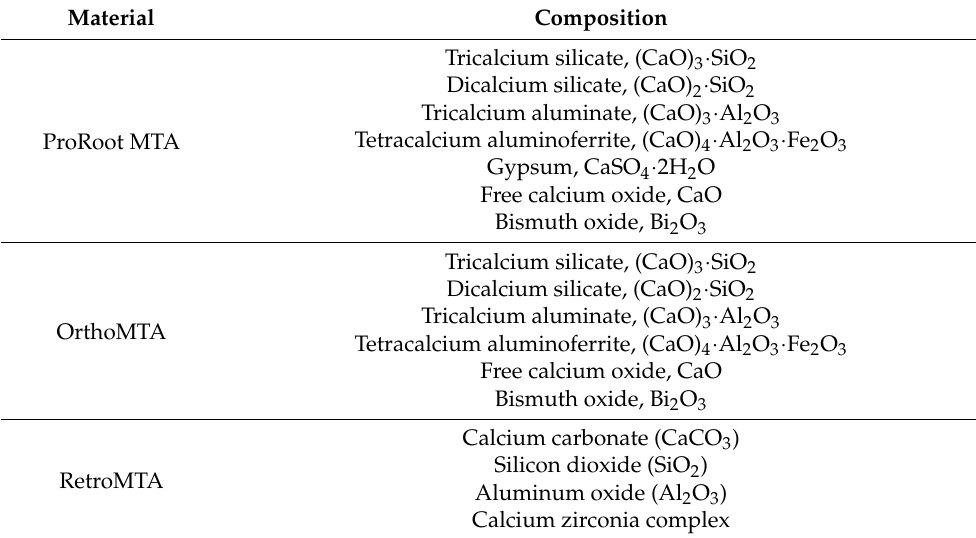
Table 1. Composition of ProRoot MTA, OrthoMTA and